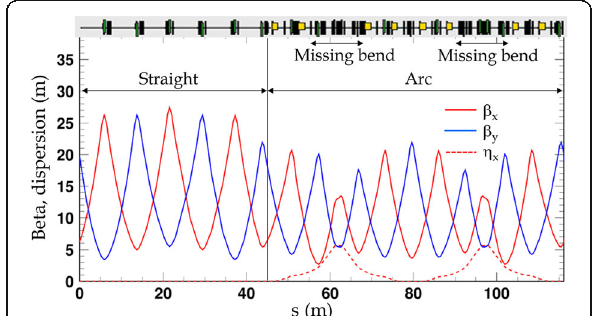
Fig. 10 Lattice and optical functions (beta amplitude and dispersion functions) of the J-PARC RCS along one